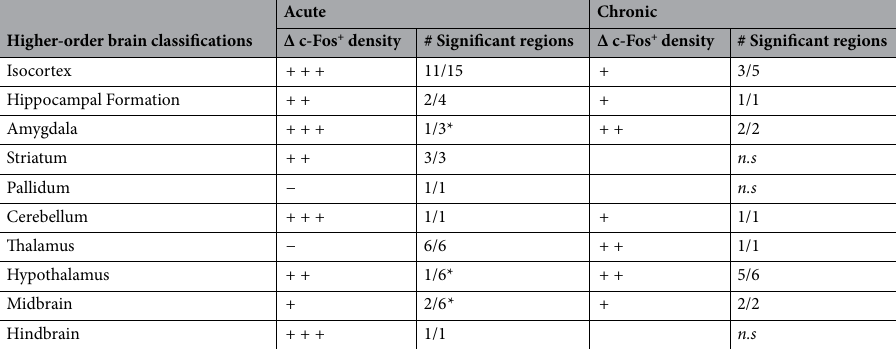
Higher-order brain